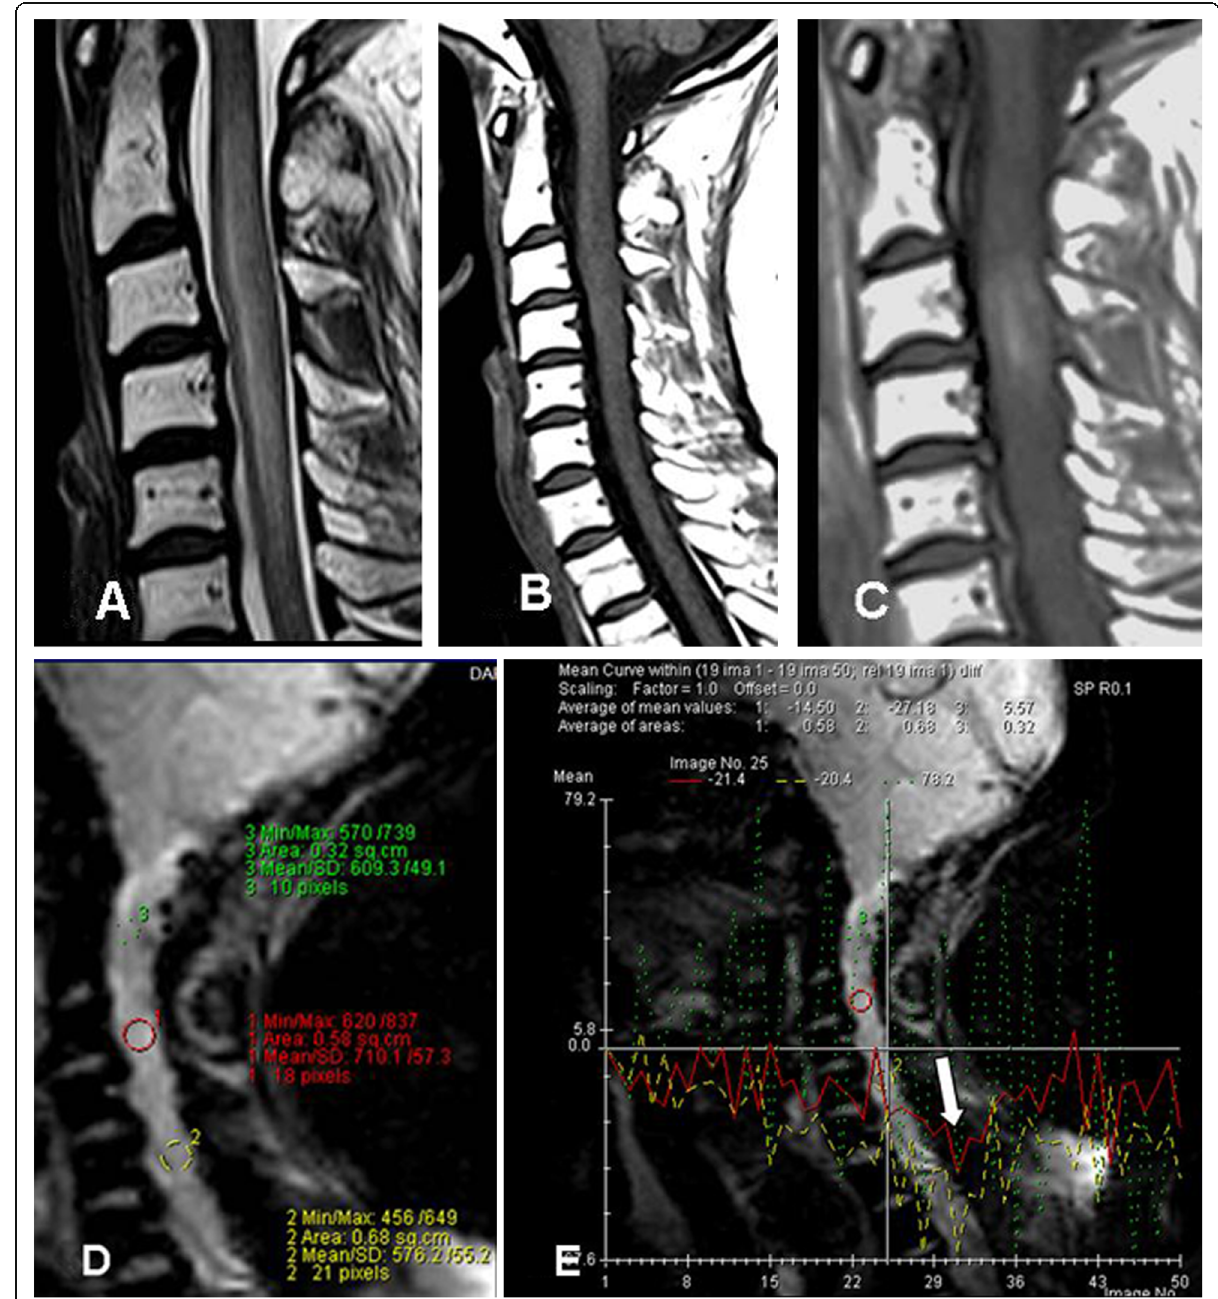
Fig. 4 Fifty-two-year-old female patient presented by neck pain and bilateral upper limb numbness, 3 months after stopping neck irradiation for oral SCC. a Sagittal T2 abnormal hyperintense signal extending from CV2 down to CV6. b Sagittal T1 pre and c post contrast showed mildly enhancing mass like lesion. d and e rCBV showing hypoperfusion of the lesion ( arrow to red curve ) in comparison to the normal cervical cord ( green and yellow curves ). Post irradiation changes were suggested. The lesion regressed on follow up confirming the